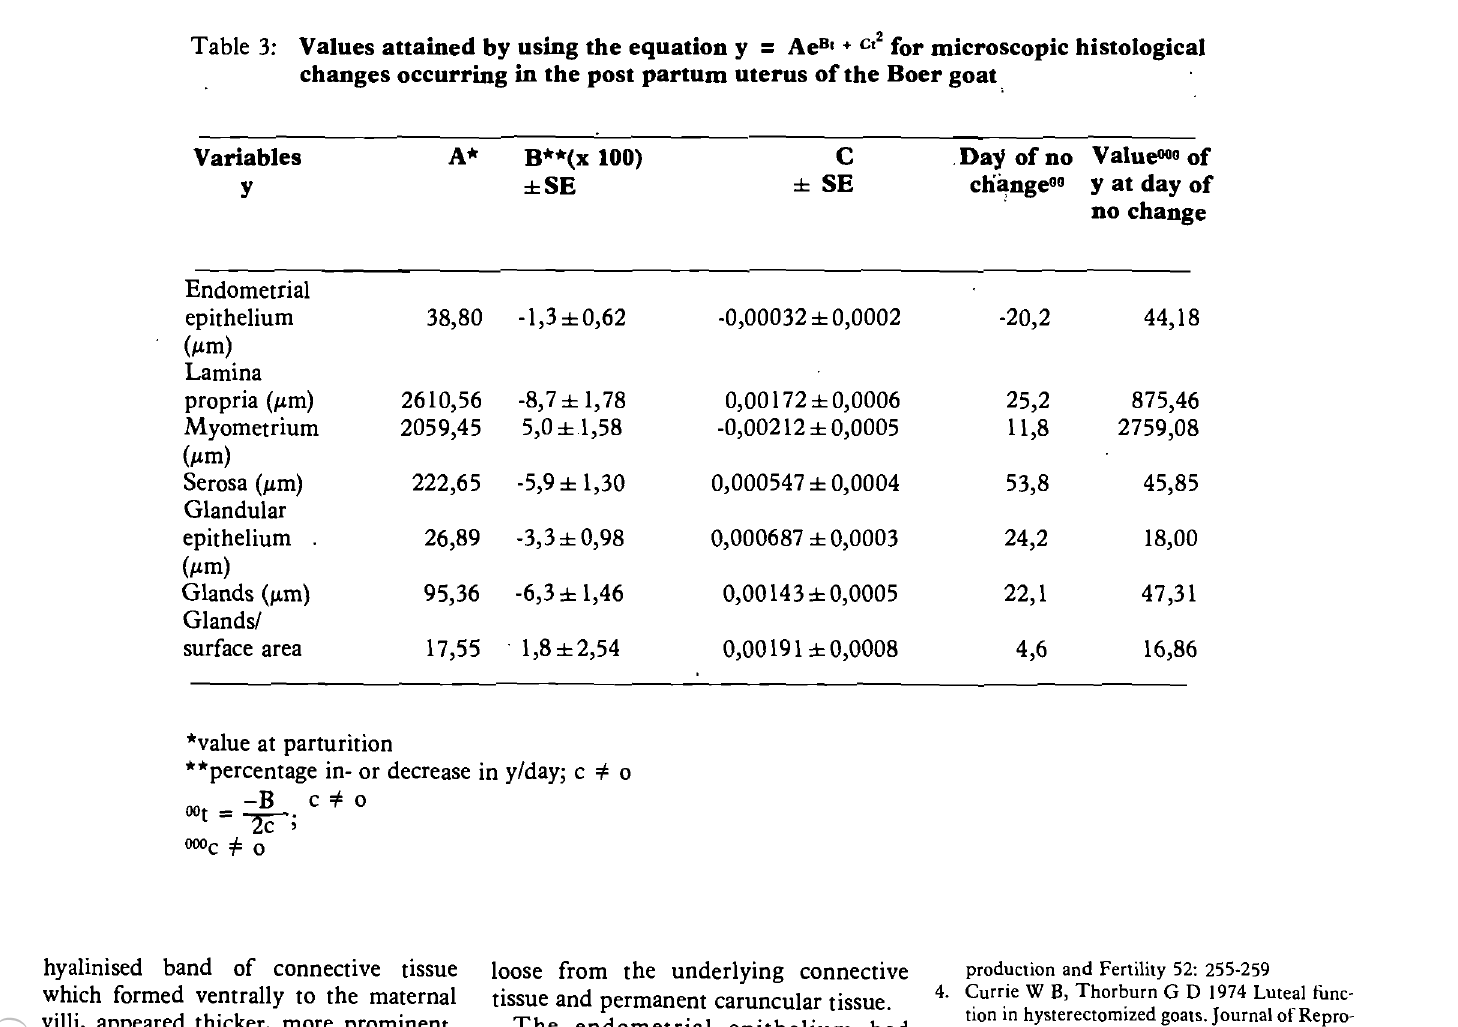
Table 3: Values attained by using the equation y changes occurring in the post partum uterus of the Boer goat;